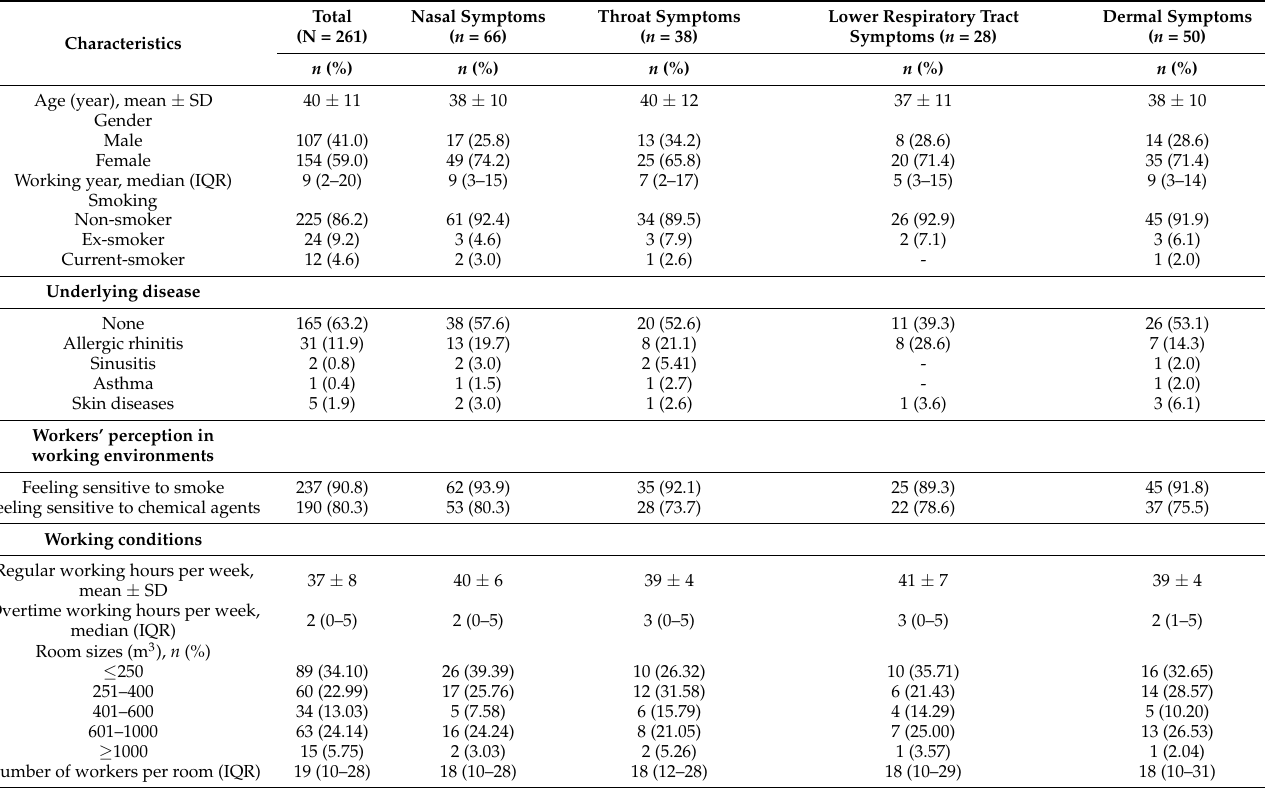
Table 1. The participants’ characteristics by SBS